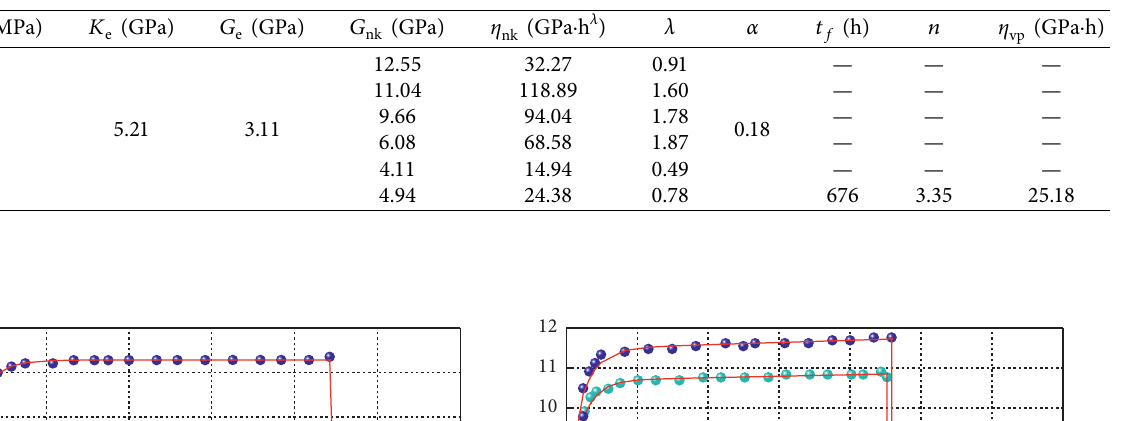
Table 4: Model parameters under triaxial creep for limestone.